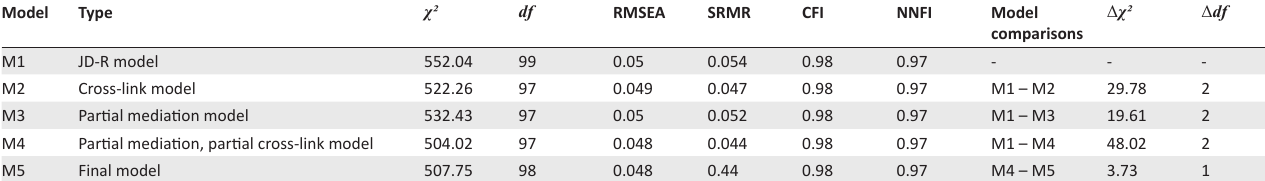
TABLE 2: Goodness-of-fit indices of the hypothesised model and the alternative models ( N = 1812). Model